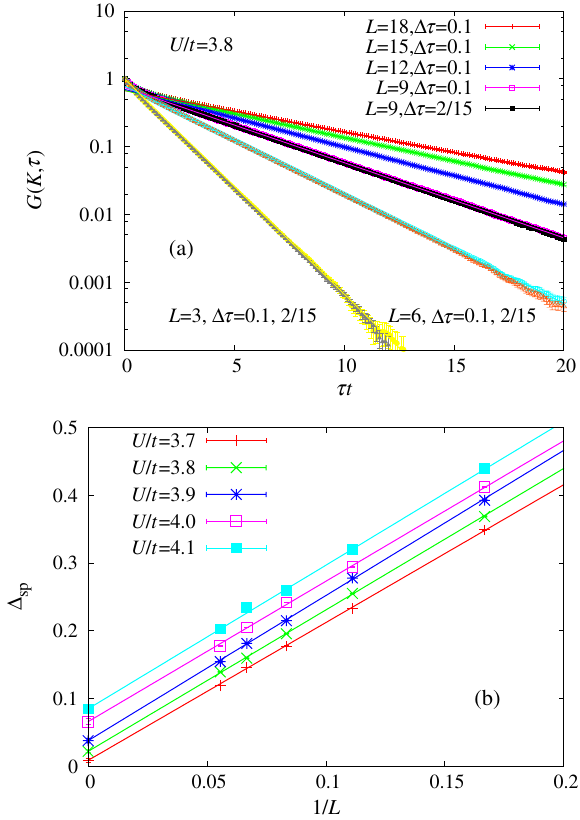
FIG. 2. Single-particle gap. (a) The raw data at U=t ¼ 3 : 8 . As is apparent, the systematic error stemming from the finite Trotter step is negligible within our accuracy. The data support a large imaginary time range consistent with a single exponential decay. Lines are least-squares fits of the tail of the imaginary time Green function to the form Ze (cid:1) (cid:2) sp (cid:7) . Here, Z corresponds to the single-particle residue and (cid:2) sp to the single-particle gap. (b) Size dependence and extrapolation of the single-particle gap.